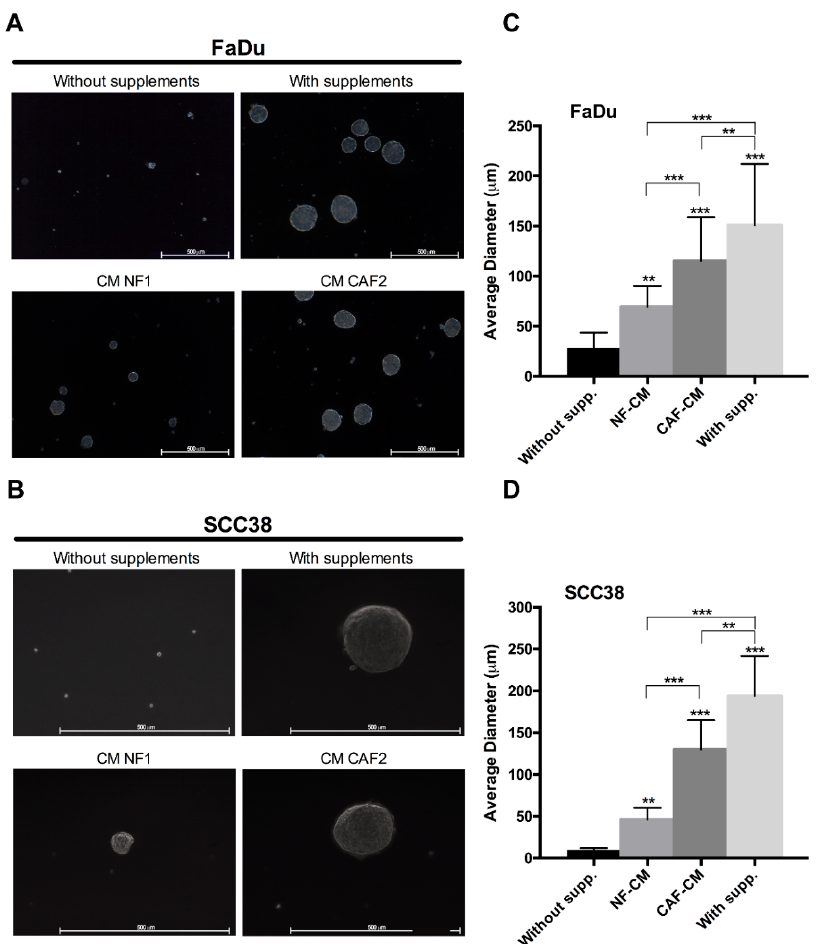
Figure 1. Effect of fibroblast-CM (conditioned media) on the tumorsphere formation capacity of head and neck squamous cell carcinomas (HNSCC) cells. Representative images of orospheres formed by ( A ) FaDu and ( B ) SCC38 cells in non-supplemented medium, supplemented medium, and CM from normal fibroblasts (NFs) or cancer-associated fibroblasts (CAFs). Bar chart showing the average diameter of spheroids formed by ( C ) FaDu and ( D ) SCC38 cells in the previous conditions. All data were expressed as the mean ± SD of at least three independent experiments performed. Scale bar: 500 µ m. *** p < 0.001 and ** p < 0.01 by Holm-Sidak’s multiple comparisons